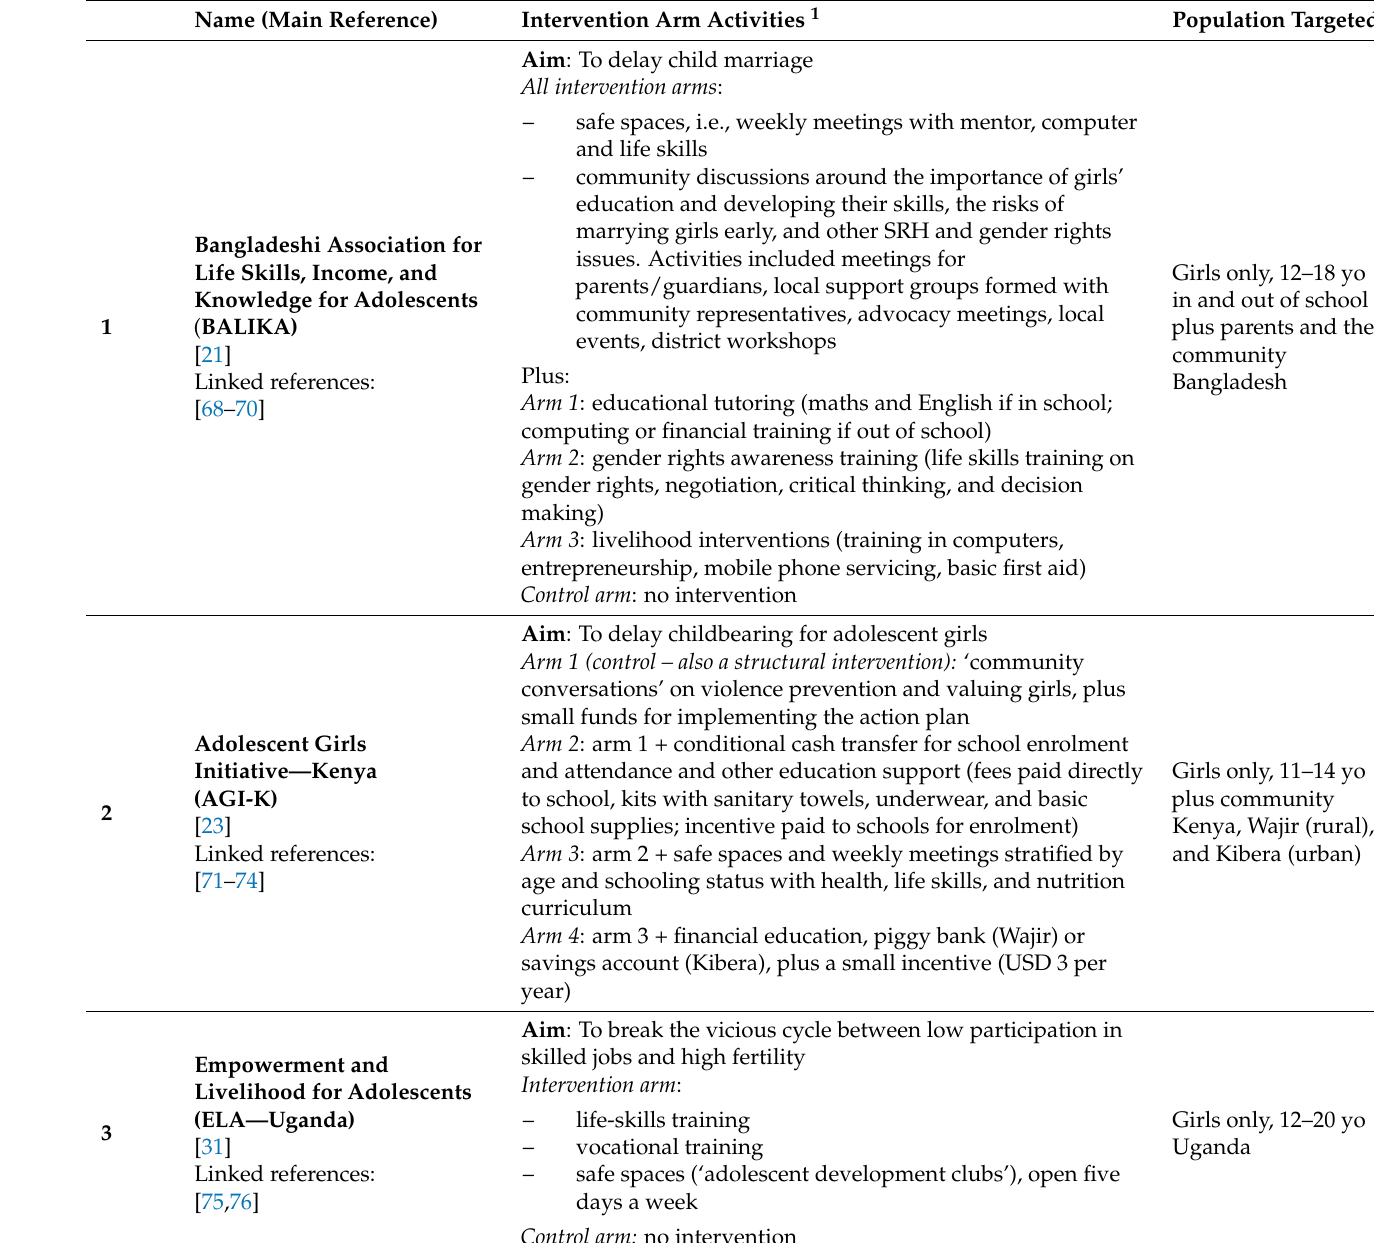
Table A1. Included studies’ intervention